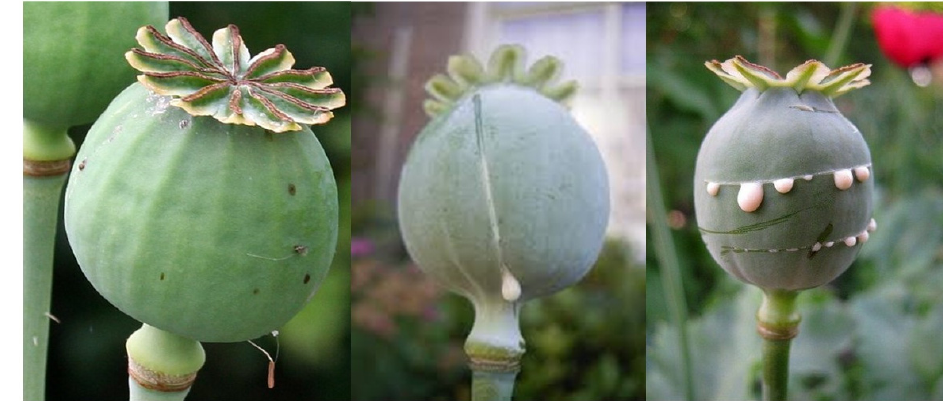
Figure 1. Opium poppy. Public domain photograph.